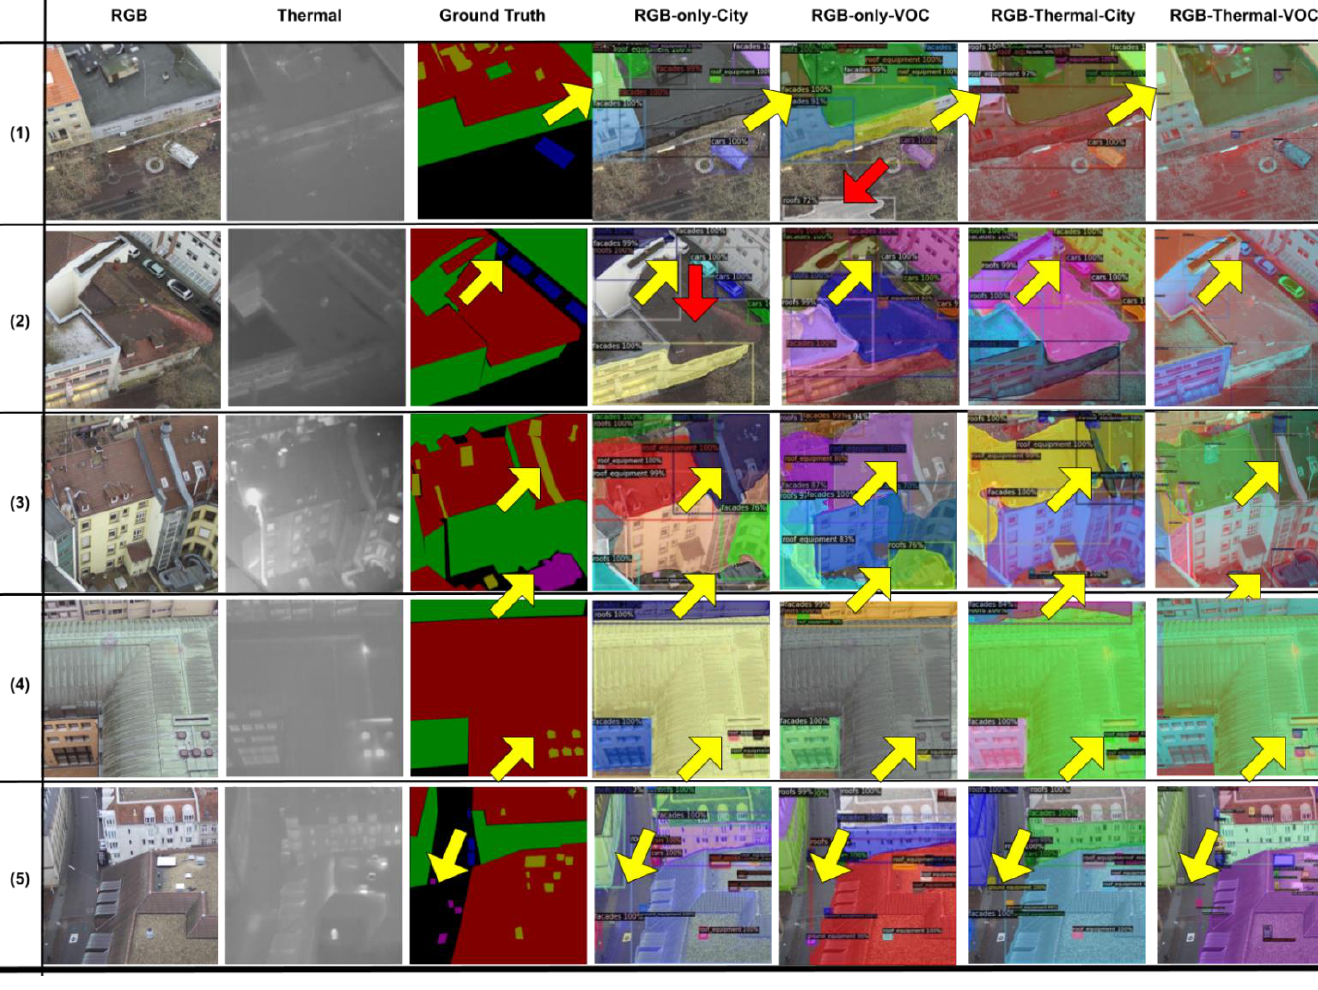
Figure 6. Instance segmentation by Mask R-CNN.